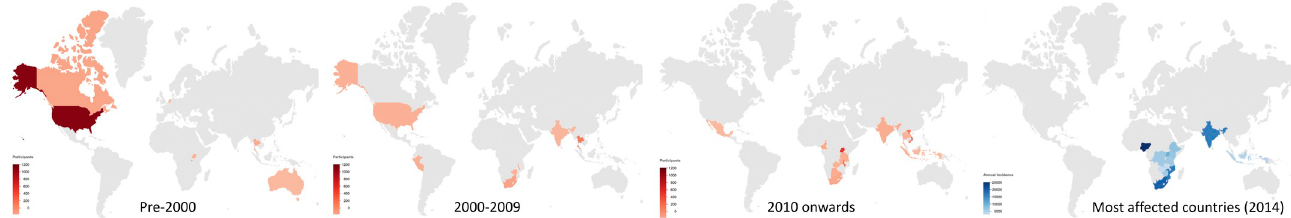
Fig 2. Number of participants recruited into HIV-associated cryptococcal meningitis cryptococcal trials by country and broken down into time periods: (A) pre- 2000, (B) 2000–2009, (C) 2010 onwards, and D) data from the global disease burden estimates identifying the 12 countries globally with the largest number of annual cases in 2014 [18]. Created using a base map available at www.displayr.com/create-a-geographic-map/.